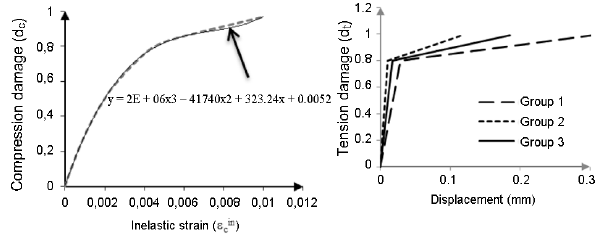
Fig. 6. Definition of concrete compression (a) and tension (b) damage parameters